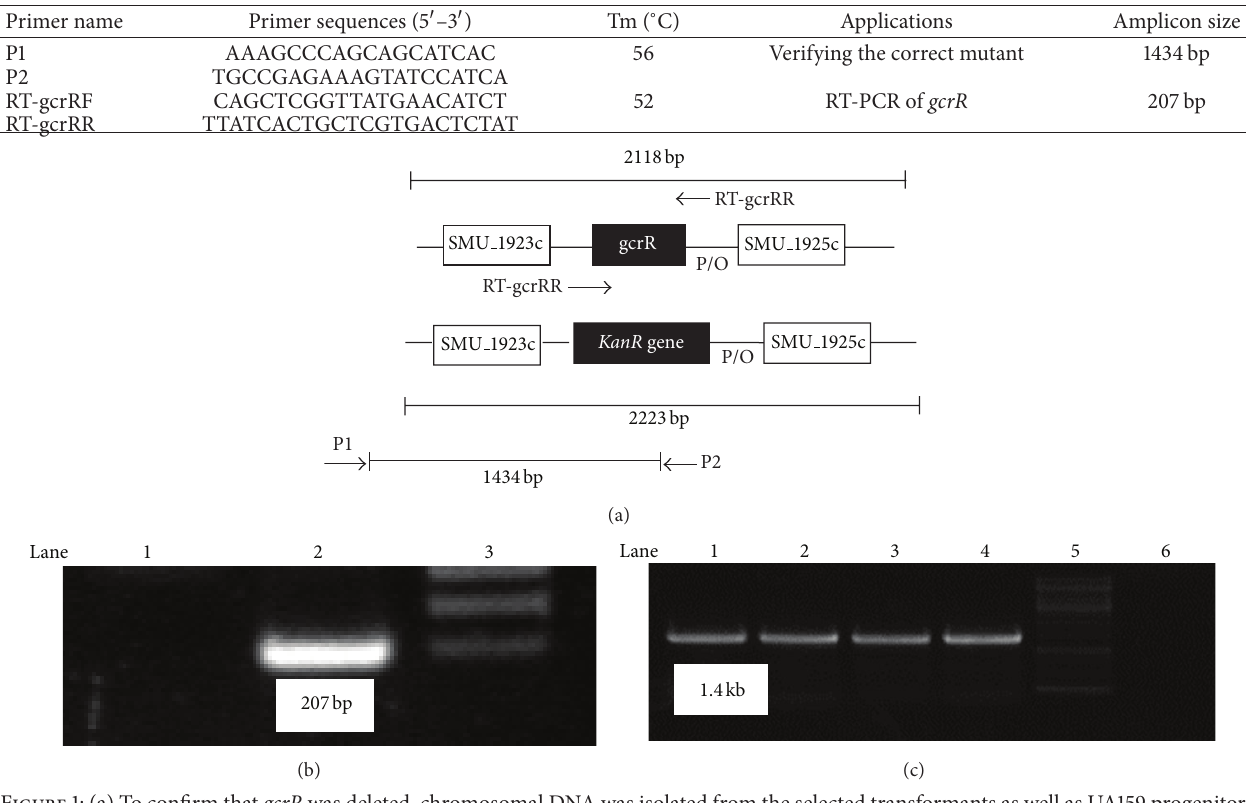
Figure 1: (a) To confirm that gcrR was deleted, chromosomal DNA was isolated from the selected transformants as well as UA159 progenitor and used as a template for PCR amplification with the P1/P2 and RT-gcrRF/RT-gcrRR primers. The resulting amplicons (the gcrR upstream- kanamycinresistance(KanR)cassettejunctionandthepartof gcrR gene)wereanalyzedviaagarosegelelectrophoresis.Nucleotidesequencing of the purified amplicons with the same primer set was conducted to confirm the gcrR knockout and KanR cassette insertion. (b) Lane 1: the resulting amplicons (chromosomal DNA of MS-gcrR-def as template and RT-gcrRF/RT-gcrRR as primers); lane 2: the resulting amplicons (chromosomal DNA of UA159 as template and RT-gcrRF/RT-gcrRR as primers); lane 3: 1kb marker (Fermentas). (c) Lanes 1, 2, 3, and 4: the resulting amplicons (chromosomal DNA of MS-gcrR-def as template and P1/P2 as primers); Lane 5, 1kb marker (Fermentas); Lane 6, the resulting amplicons (chromosomal DNA of UA159 as template and P1/P2 as